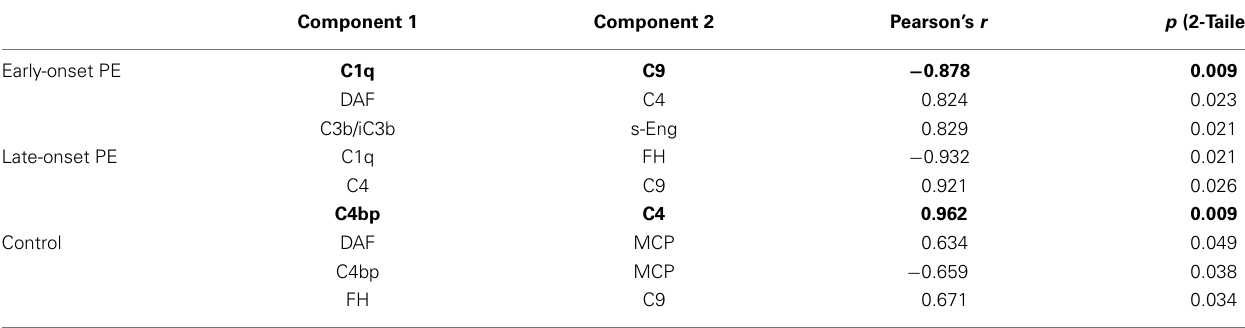
Table 7 | Correlations of high-intensity area percentage values between different components per patient group